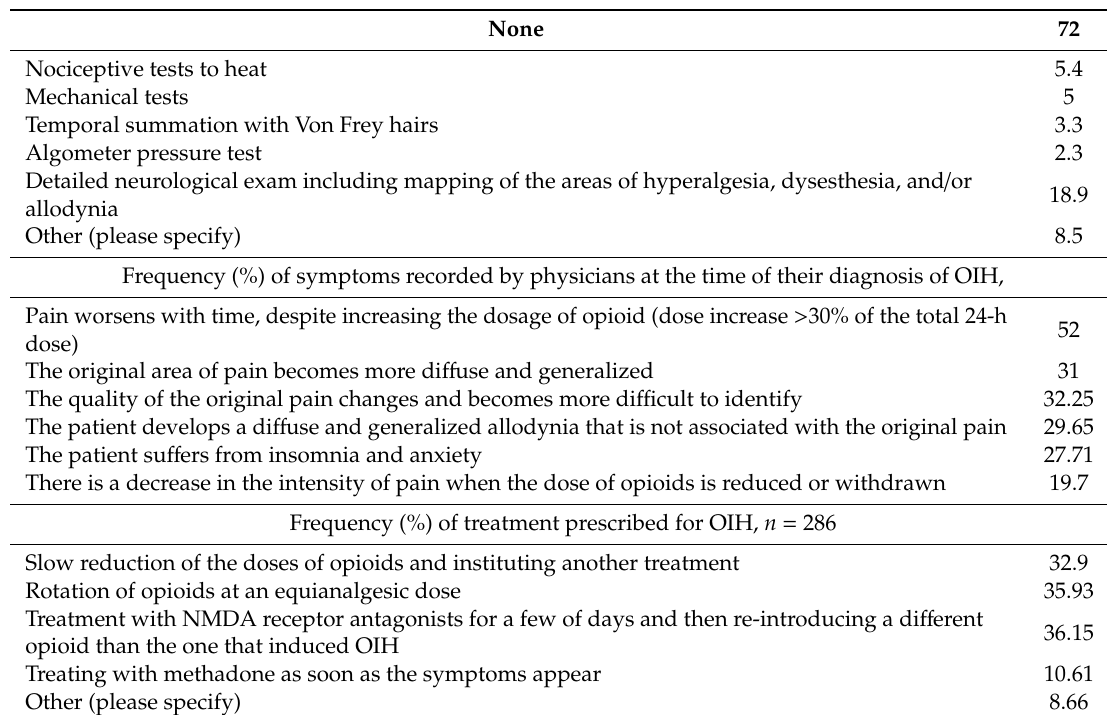
Table 2. Frequency (%) of tests performed to diagnose OIH, frequency (%) of symptoms recorded, and frequency (%) of treatment prescribed.